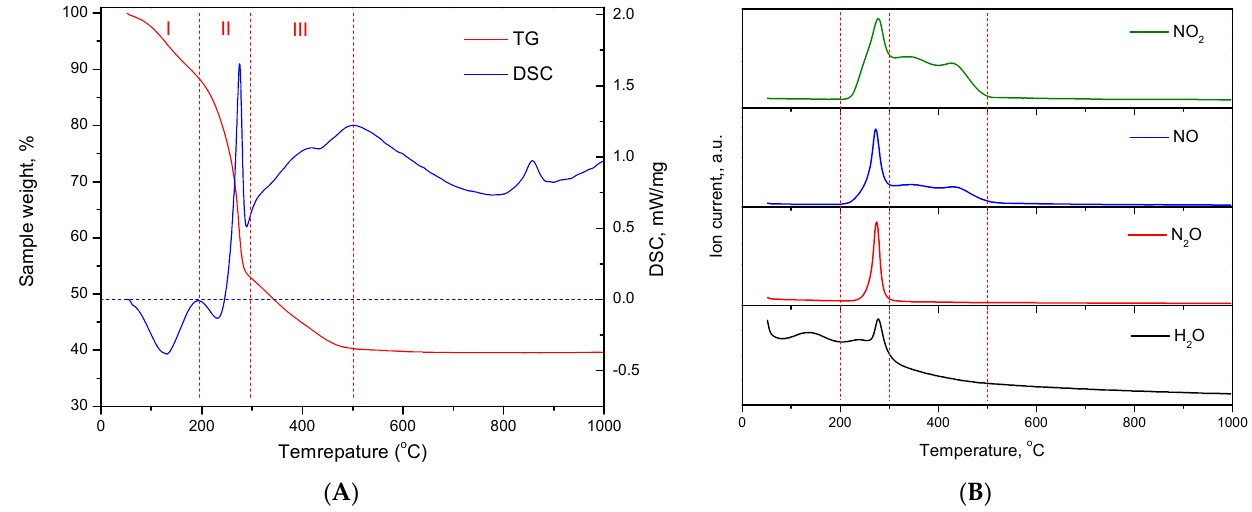
Figure 4. Thermal analysis ( A ) and mass-ion curves ( B ) of the Al-5 sample. Table 3. Results of thermal analysis. The total weight loss of the samples and the content of nitrate ions associated with aluminum are generally in good agreement with the ionometric data. Figure 5 shows the